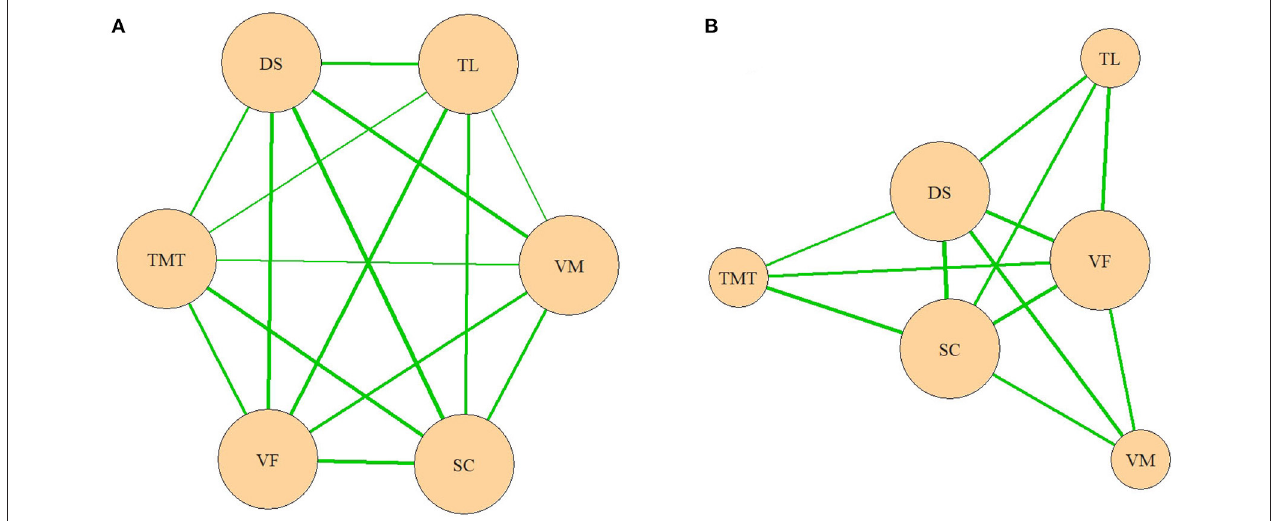
FIGURE 3 | (A,B) Network model of neurocognitive functions. VM, test for verbal memory; DS, Digit Sequencing test, which evaluates working memory; TMT, Token Motor Task; VF, Verbal fluency test; SC, Symbol Coding test, which evaluates attention and processing speed; TL, test “Tower of London”, which evaluates executive functions.